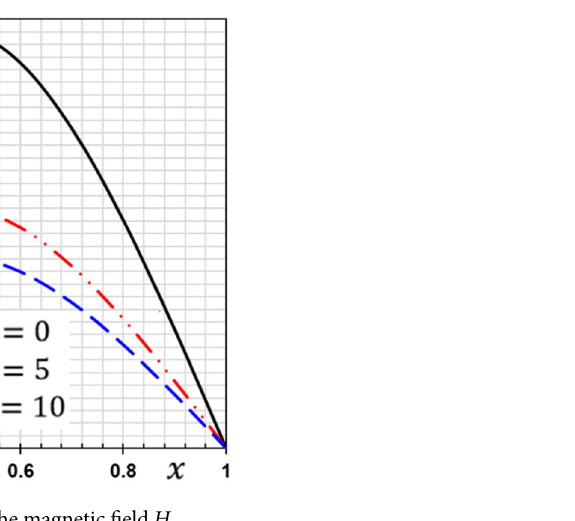
Figure 17. The flexure moment M with the magnetic field H x